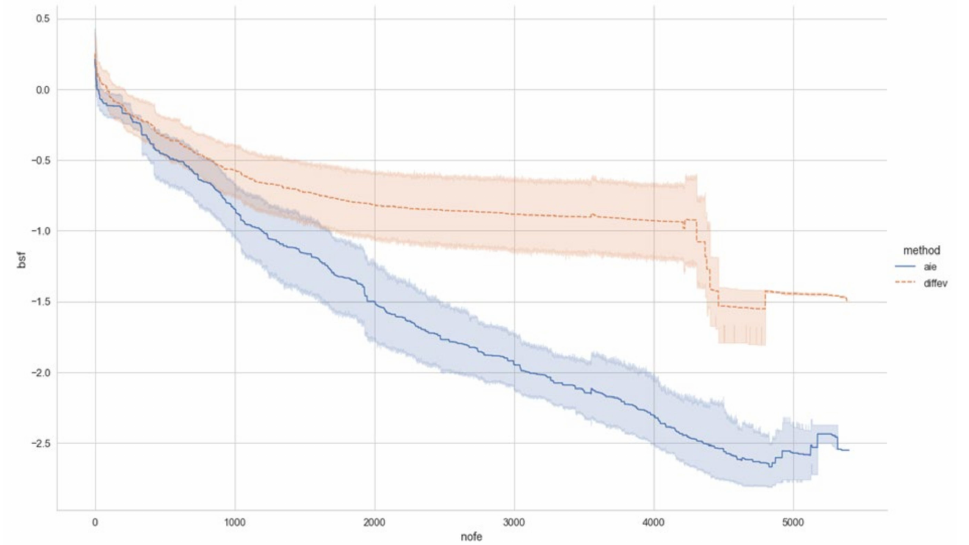
Figure 2. Comparison of fitness spread in 20 runs, 350 generation, ATE and AIE algorithms with analytical objective